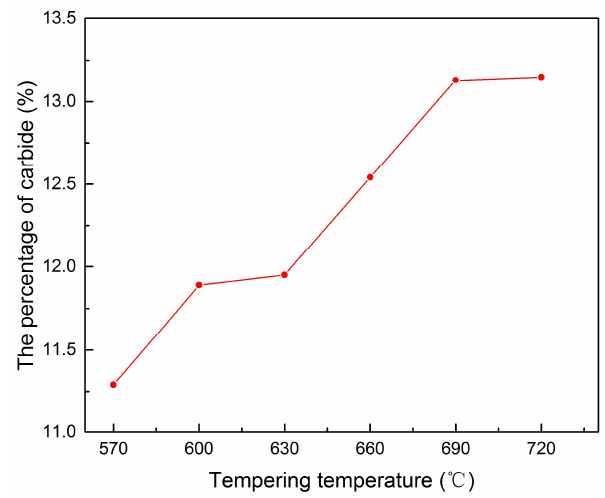
Figure 9. Percentage of carbides in 42CrMo4-V steel tempered at 570–720 °C.